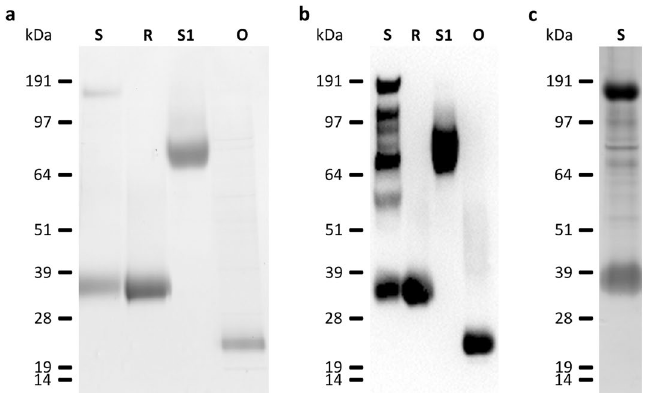
Figure 1. Recombinant SARS-CoV-2 proteins. ( a ) 4–12% Bis–Tris gel loaded with 4 µg of SARS-CoV-2 spike protein (S), the RBD of spike protein (R), subunit 1 of the spike protein (S1), and ORF8 protein (O) stained with Coomassie brilliant blue R 250. ( b ) Immunoblot with 2 µg of Strep-tagged SARS-CoV-2 proteins loaded in the same manner as the Coomassie gel in ( a ), and detected with a Strep-Tactin-HRP conjugate. ( c ) Silver staining with 2 µg of SARS-CoV-2 S protein loaded in the same manner as the Coomassie gel in ( a ). All cropped lanes of different immunoblots or gels are divided by white space. Immunoblots and gels were only cut in width and lanes are shown in their full